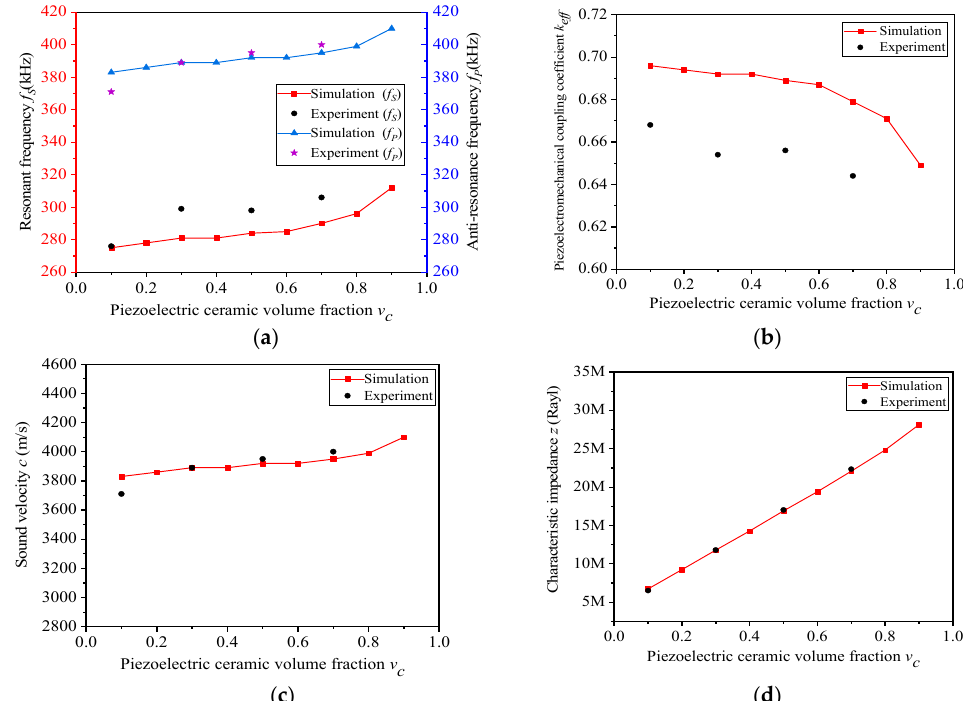
Figure 9. ( a – d ) Experimental performance of composite with different v c (v s = 0.6).